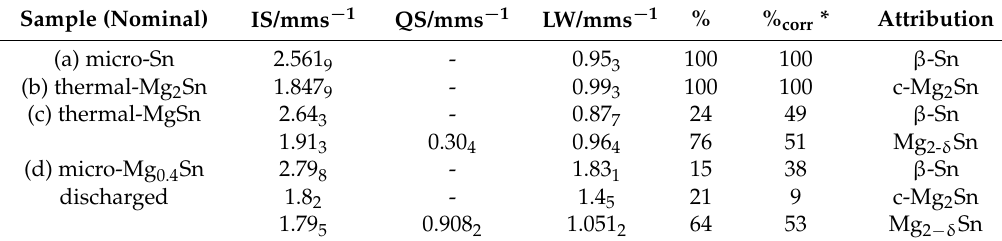
Isomer shift (IS), quadrupolar splitting (QS), line width (LW), % contribution and attribution of the signals appearing in the 119 Sn Mössbauer spectra of commercial micro- and nano-Sn, mechanochemically produced Mg 2 Sn. and discharged/recharged electrodes. * Recoilless fractions, f = 0.05 (Sn). Reproduced with permission of [28,29]. Copyright Elsevier, 2000, 1966. f = 0.3 (c-Mg 2 Sn) Reproduced with permission of [29]. Copyright Elsevier, 1966. f = 0.15 (Mg 2 − δ Sn; ca. half of